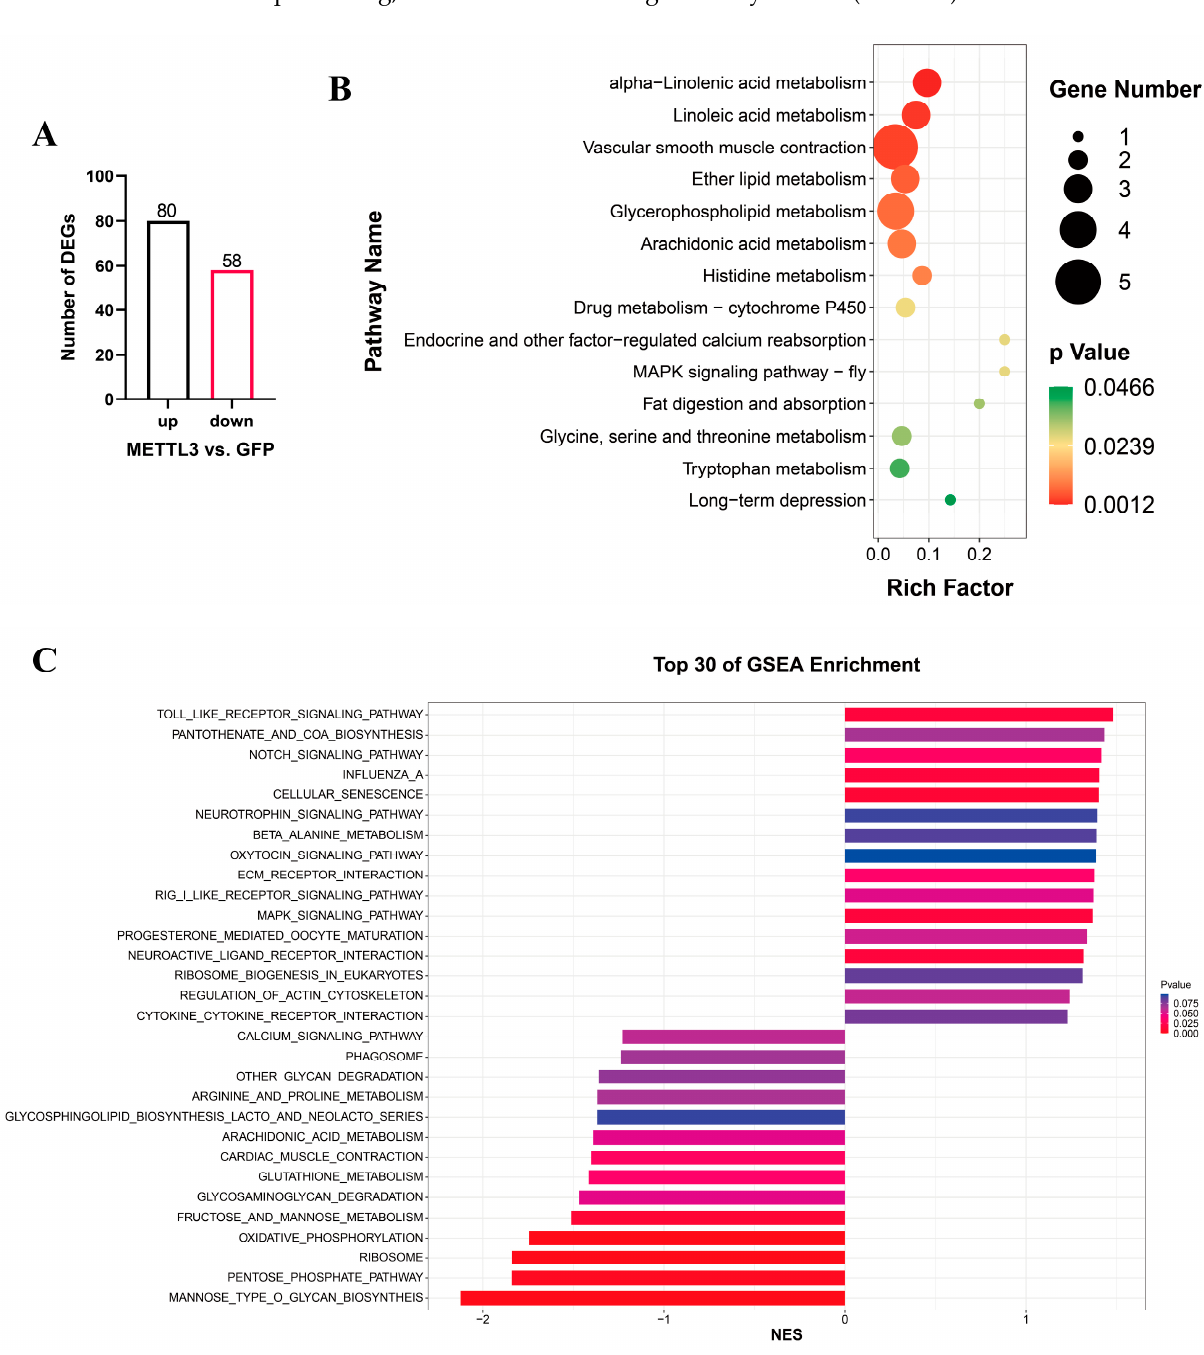
Figure 5. RNA-seq analysis in QM7 cells overexpressing METTL3 . ( A ) The number of differentially expressed genes (DEGs) after METTL3 overexpression. ( B ) KEGG pathway enrichment analysis relating to the di ff erentially expressed genes. ( C ) The top 30 enriched KEGG pathways based on GSEA with the RNA-seq data.